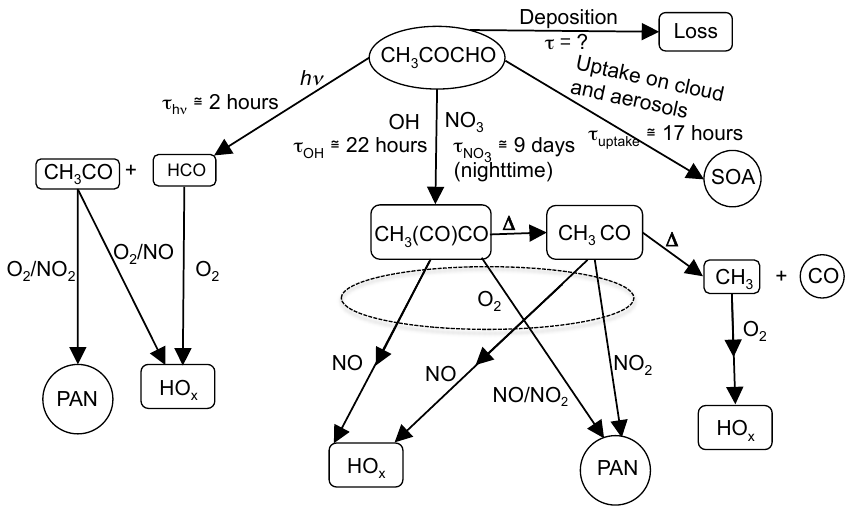
Fig. 1. Simplified atmospheric degradation scheme for methylglyoxal highlighting loss via UV photolysis, OH radical reaction, NO 3 radical reaction, and cloud and aerosol uptake. Approximate atmospheric lifetimes are included (see text for